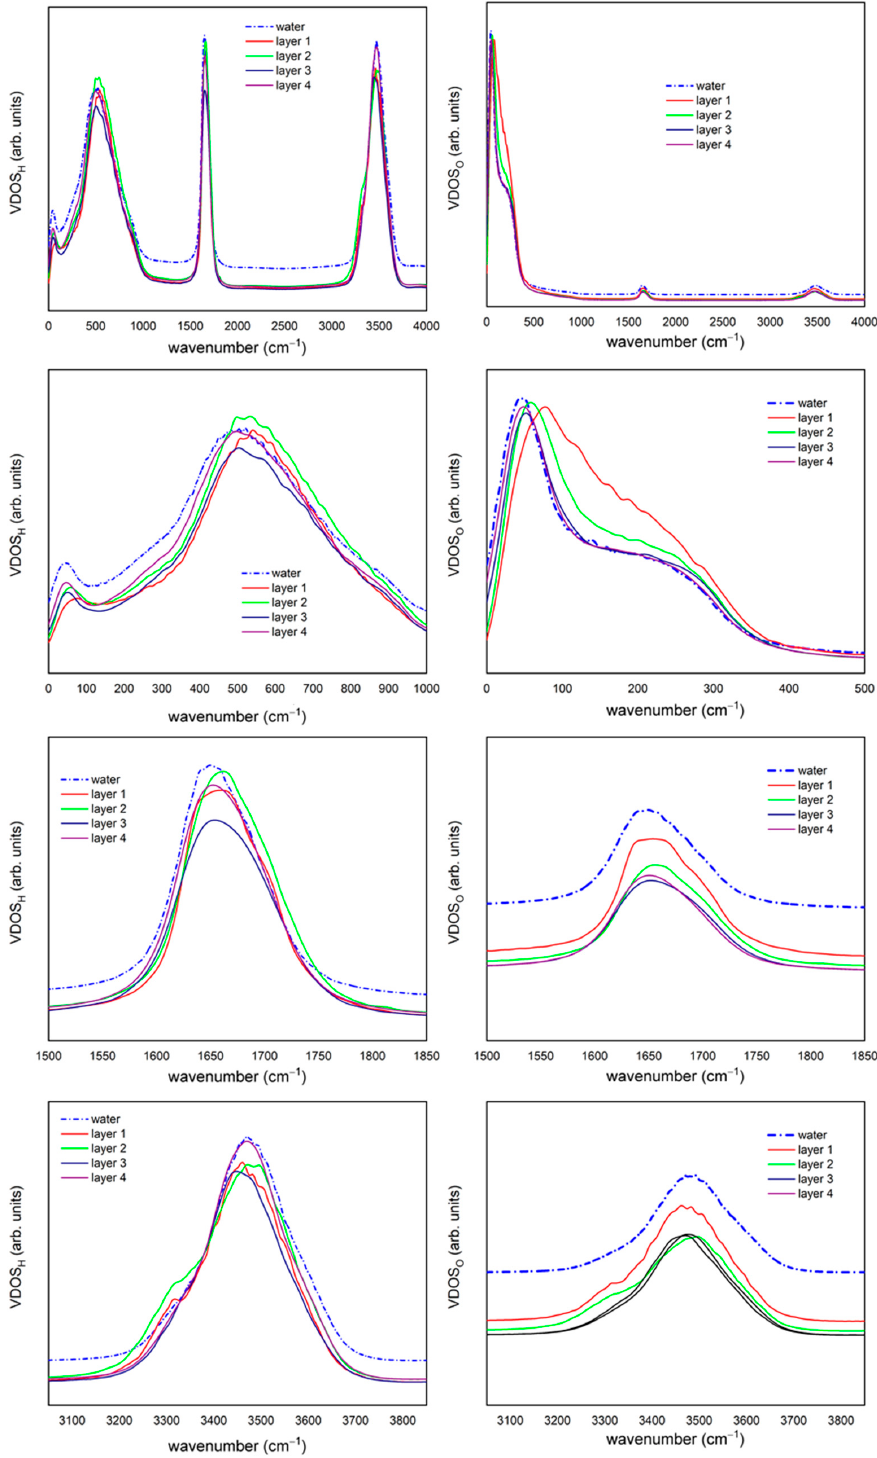
Figure 2. Vibration density of states for hydrogen ( left ) and oxygen ( right ) for first (red), second (green), third (dark blue), and fourth (purple) solvation sub-layers considered and liquid water (blue, line-dot-line). Full frequency range in the first row, the very low frequencies, e.g., acoustic, optic and librational regions, in the second row, H-O-H bending region in the third row and H-O stretching region in the fourth row.